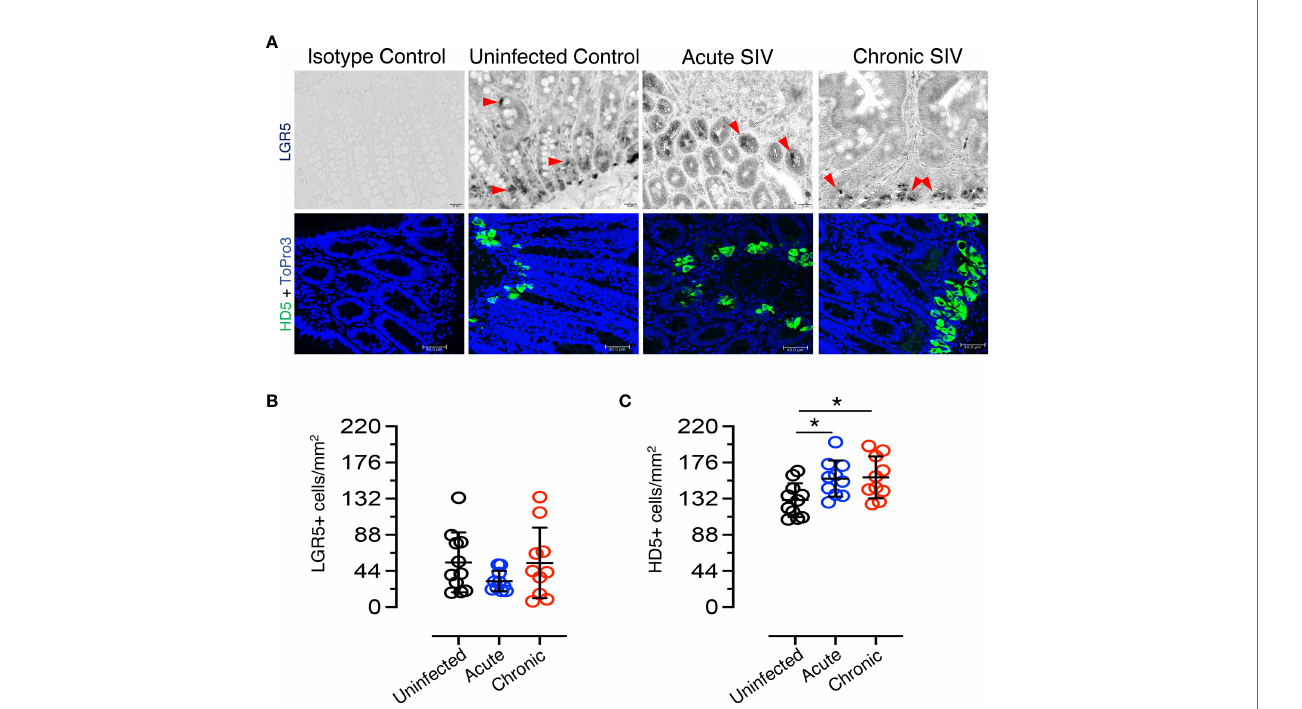
FIGURE 3 | Dynamics of LGR5+ intestinal stem cells and HD5+ Paneth cells in SIV infection. (A) Top panels: LGR5+ staining; bottom panels: HD5 staining. Representative isotype control for LGR5 showing the absence of nonspeci fi c background staining (macaque number FK25). LGR5+ cells from uninfected (macaque FK25), acute SIV (macaque EM64 at 21 days post infection), and chronic SIV (macaque FK88, 226 days post infection) RhMs are shown. The red arrows are representative of selected LGR5+ cells. HD5+ cells increase in SIV-infected RhM jejunum as detected by immuno fl uorescence staining. Representative isotype control for HD5 showing the absence of nonspeci fi c background staining from an SIV-uninfected RhMs (macaque number AG71). Representative images of HD5+ cells in SIV-uninfected (macaque AG71), SIV acute (macaque EK98 at 21 days post infection), and SIV chronically (macaque FK88 at 226 days post infection) infected RhMs are shown. ToPro3 stains cell nucleus. Scatter plots of LGR5+ (B) and HD5+ (C) cells are shown for jejunum in normal (n=11), acutely (n=10) and chronically (n=10) SIV-infected RhMs . An average 19-20 fi elds was randomly selected for each animal. The number of positive LGR5+ or HD5+ cells in each fi eld was counted. Each point in the scatter plot represents the average number of positive cells from all the fi elds of each animal. The larger horizontal line denotes the mean frequencies (± standard deviation) of each category. Statistically signi fi cant differences of LGR5+ or HD5+ cell frequency among normal and SIV infected RhMs determined with one way ANOVA followed by Tukey-Kramer multiple comparison analysis as indicated with asterisks (* p <